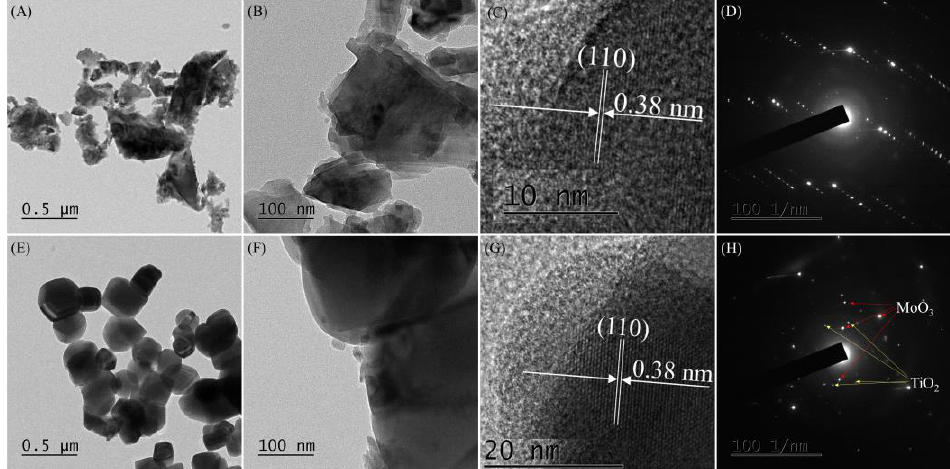
Figure 2. ( A – C ) TEM images of MoO 3 , ( E – G ) Ti-Mo NC, ( D ) SAED patterns of MoO 3 , and ( H ) Ti-Mo NC.